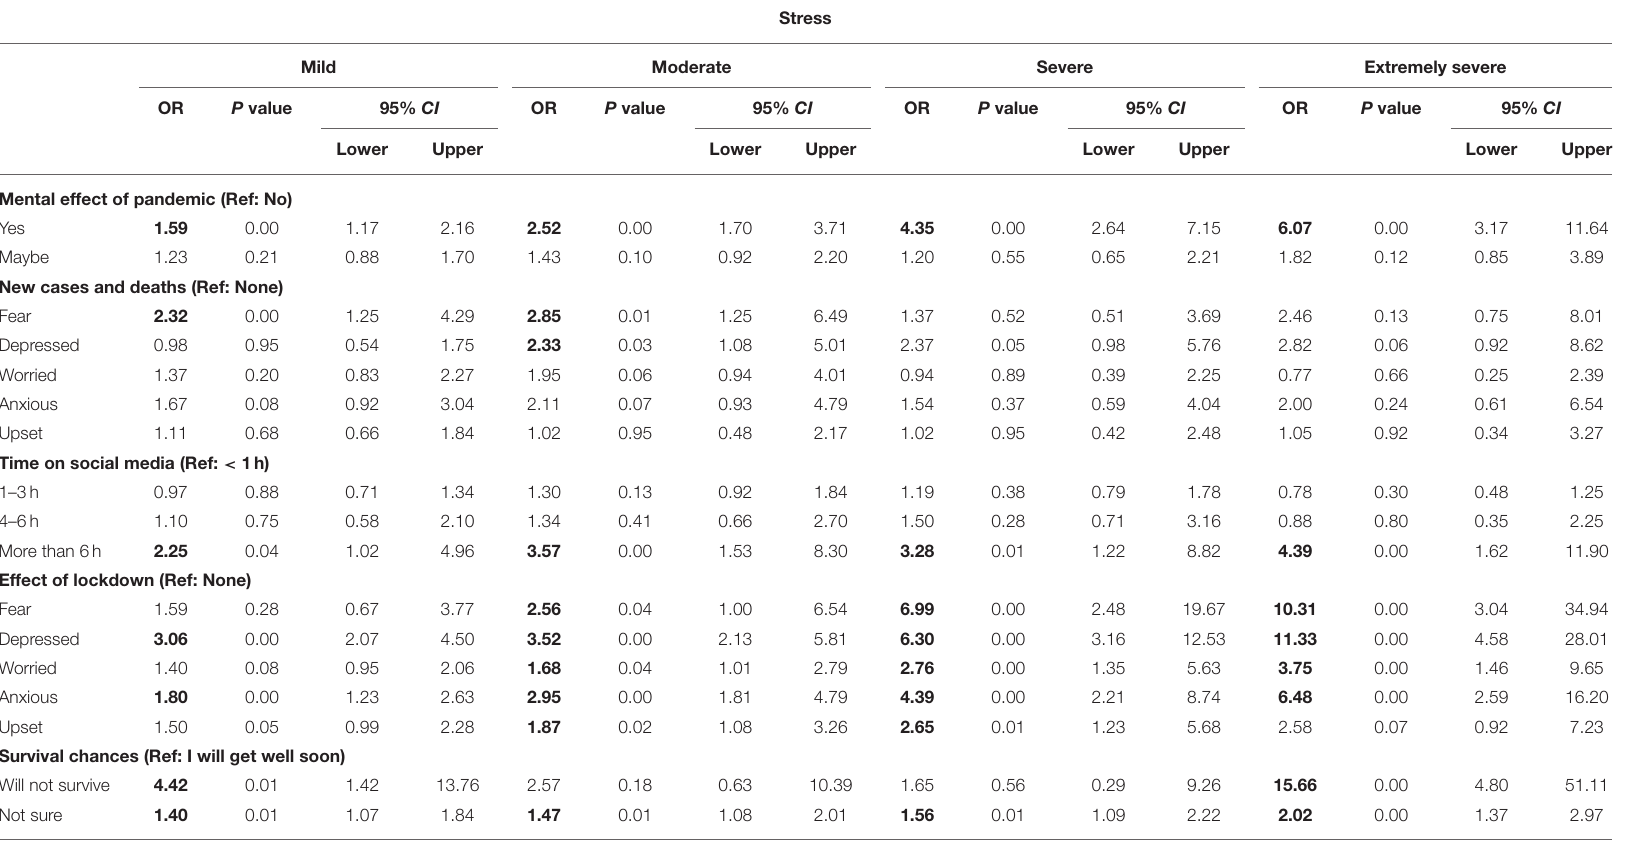
TABLE 4C | Association of level of severity of stress with the personal feeling variable identified with multinomial logistic regression. Stress Mild Moderate Severe Extremely severe OR P value 95% CI OR P value 95% CI OR P value 95% CI OR P value 95% CI Lower Upper Lower Upper Lower Upper Lower